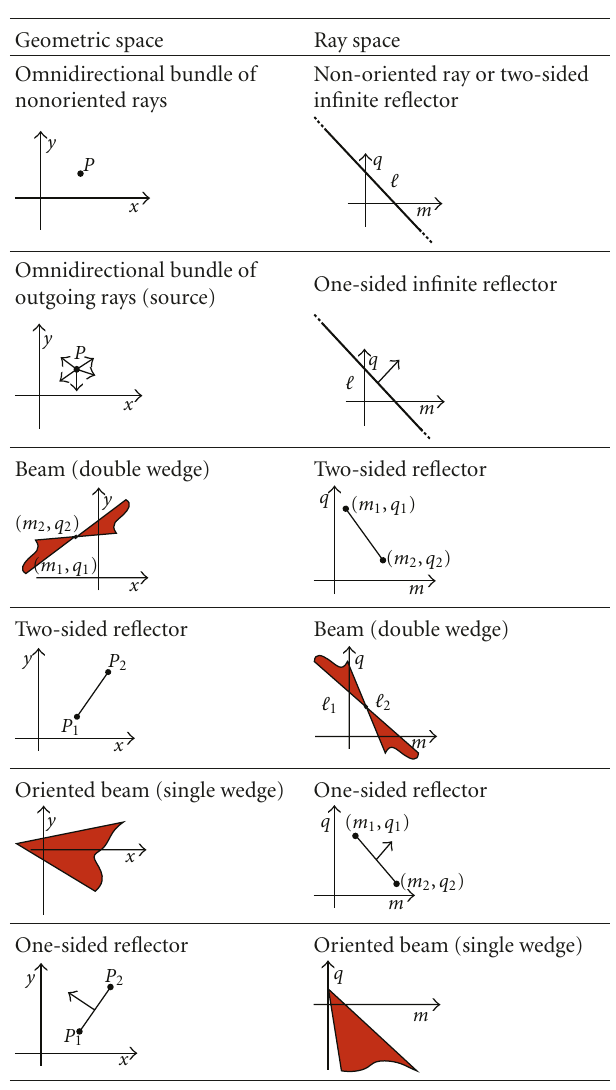
Table 1: Primitives in the geometric domain and their correspond- ing representation in ray